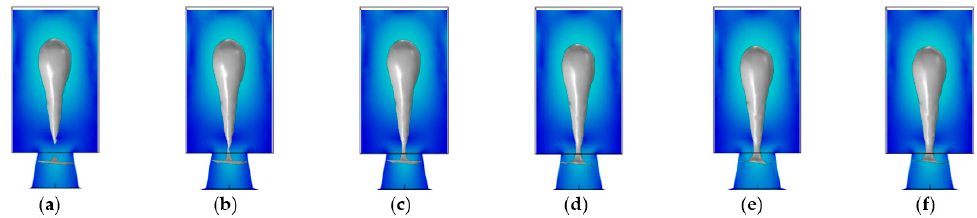
Figure 5. Fracture state of liquid column at different contact angles. ( a ) The contact angle is 30°; ( b ) The contact angle is 50°; ( c ) The contact angle is 70°; ( d ) The contact angle is 90°; ( e ) The contact angle is 110°; ( f ) The contact angle is 130°.